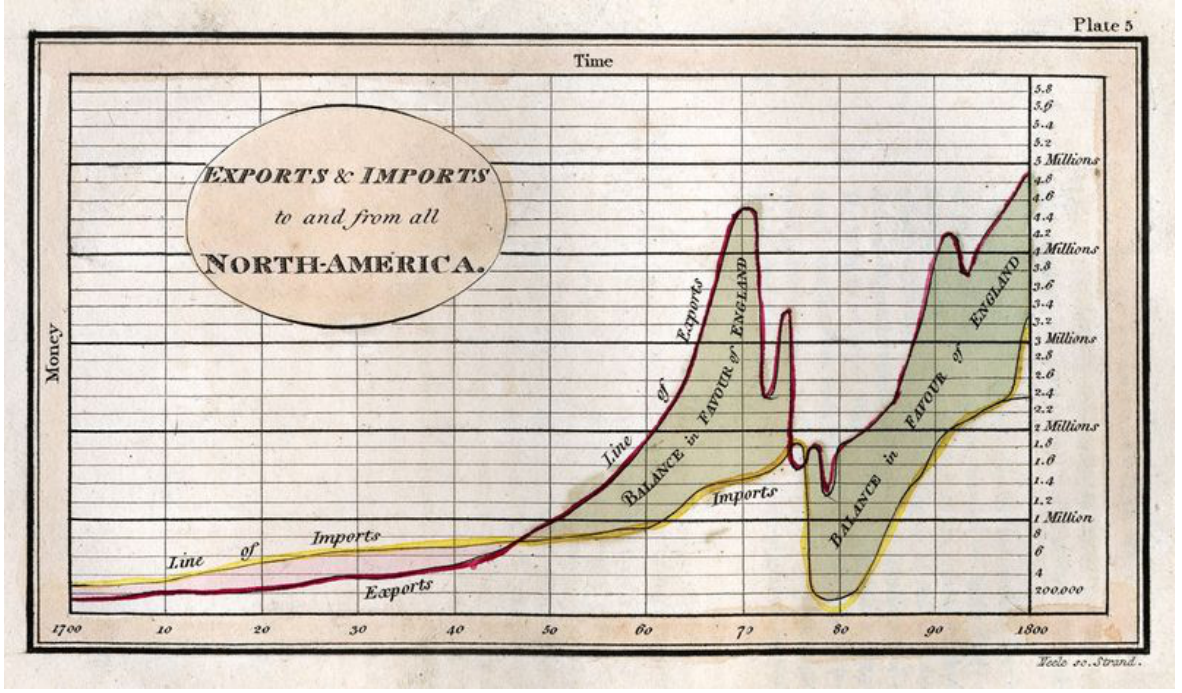
Figure 21. “Exports & Imports to and from all North-America,” from The Commercial and Political Atlas (Playfair, 1801). Image courtesy of the Library Company of Philadelphia,